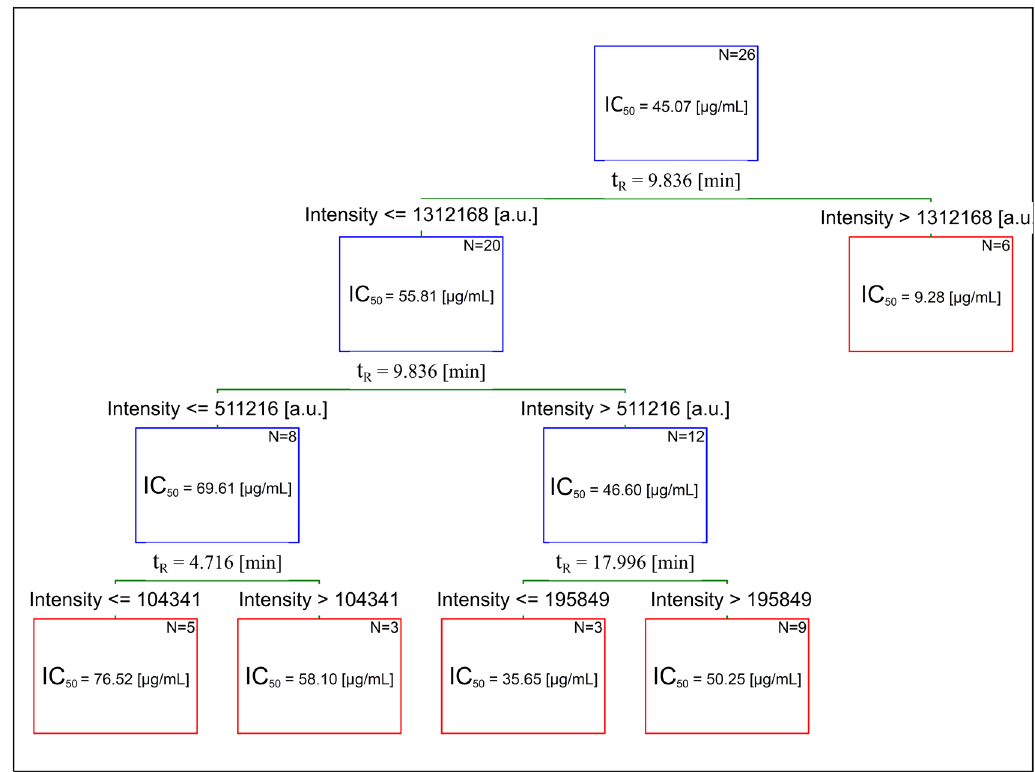
Figure 6. The tree graph for IC